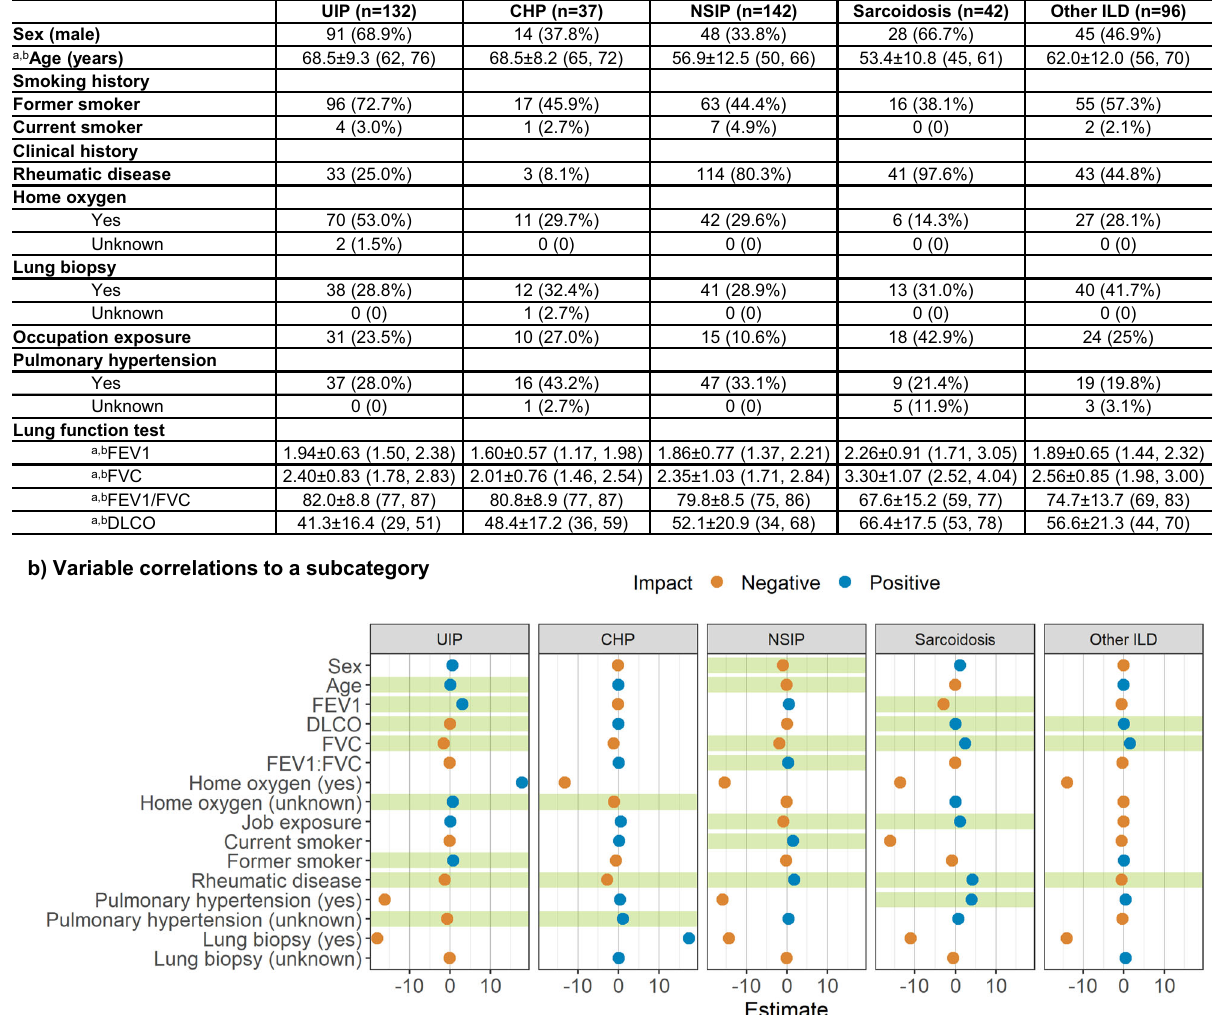
between clinical information and each ILD subcategory. The x-axis indicates the coef fi cient of each clinical variable evaluated by logistic regression. Green shades show a signi fi cant